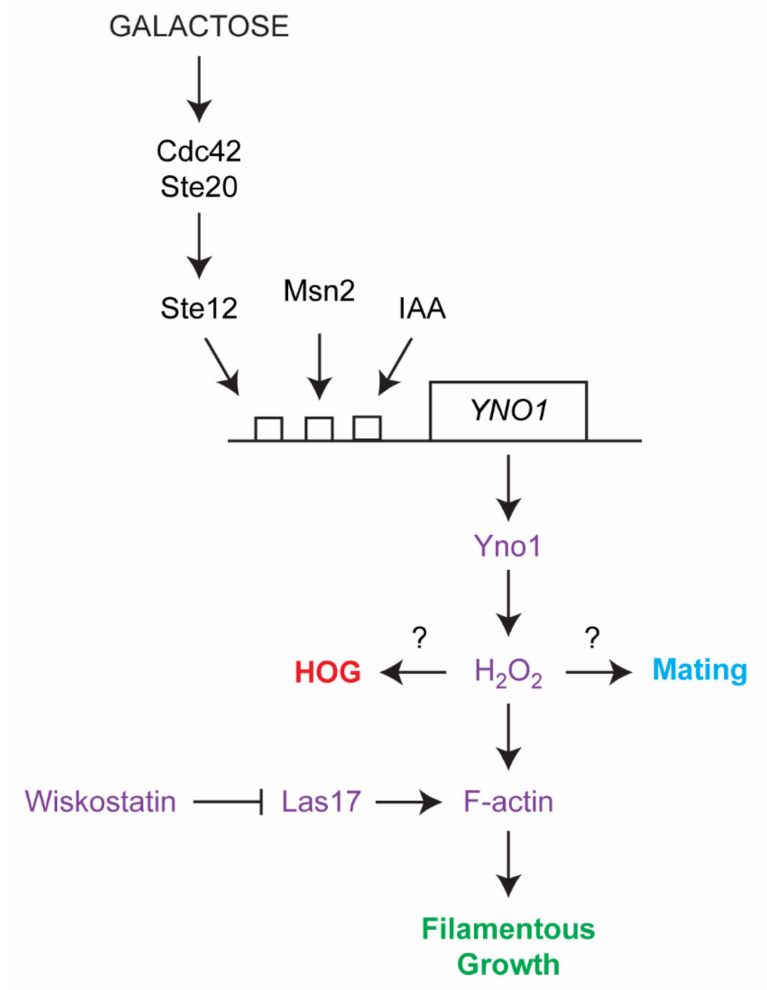
Figure 10. Model for the action Yno1p during filamentous growth. Galactose induces filamentous growth. The transcription factors Ste12p and Msn2p are activated via Cdc42p/Ste20p and promotes the expression of the Yno1p gene. IAA treatment induces filamentous growth and YNO1 expression independent of Ste12p. Yno1p in an interplay with Sod1p produces hydrogen peroxide that is involved in pheromone response (blue letters), osmotic stress response (red letters) and filamentous growth (green letters). An additional target of Yno1p-derived ROS is the actin assembly factor Las17p that promotes the nucleation of F-actin (purple letters). Our data indicate that stabilized F-actin may impact filamentous/invasive